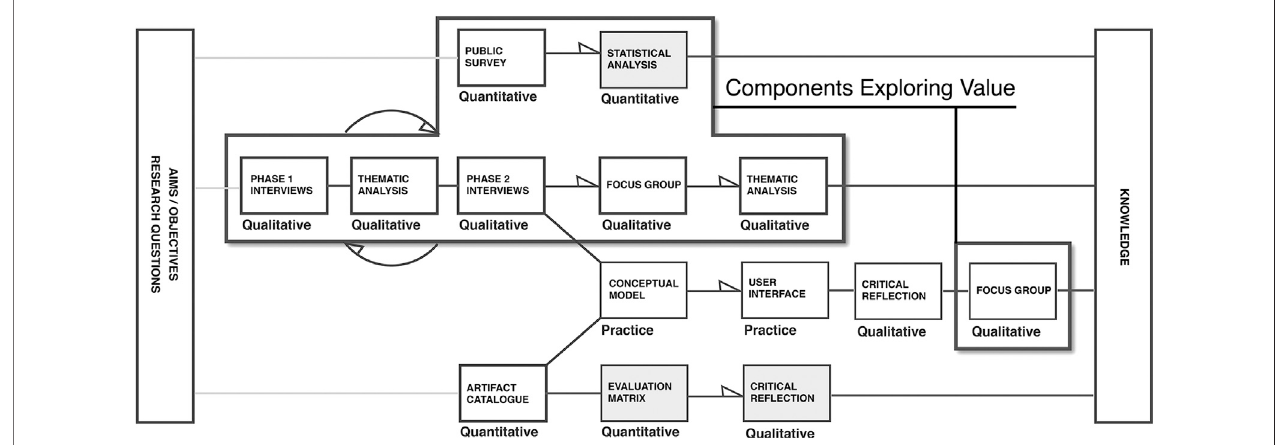
FIGURE 1 | Diagram mapping the components of the broader doctoral research highlighting elements relative to value